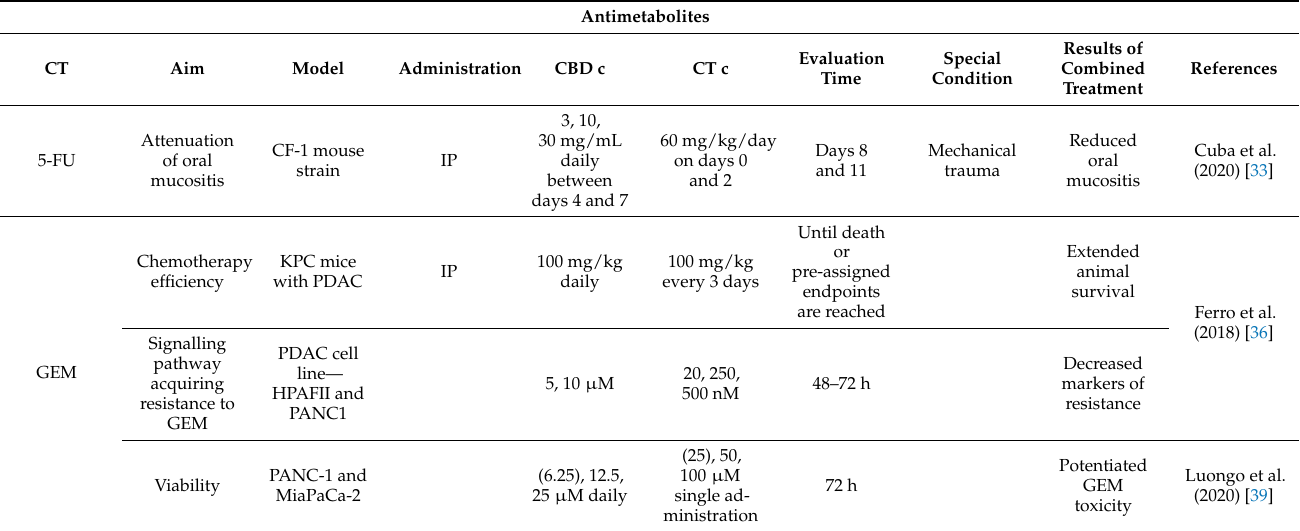
Table 1. Summary of the drug–drug interactions of CBD with antimetabolites.